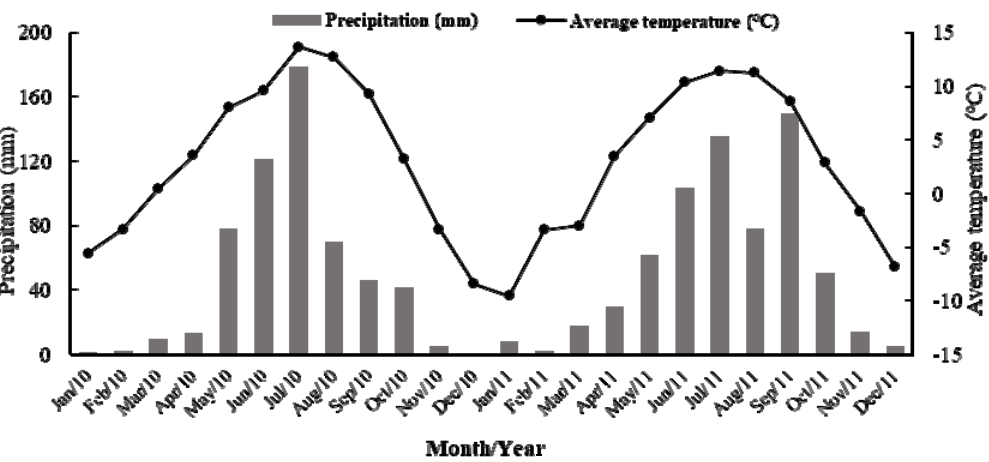
Figure 1. Mean monthly precipitation and temperature from January 2010 to December 2011 at the experimental site located in an experimental pasture farm in Maqu County (35°58'N; 101°53'E) on the Qinghai–Tibetan Plateau (QTP). Temperature: average 2.9 °C; high 13.7 °C; low 9.5 °C. Rainfall: average 50.8 mm; high 178.8 mm; low 0.5 mm (Data from Maqu County Meteorological Station).